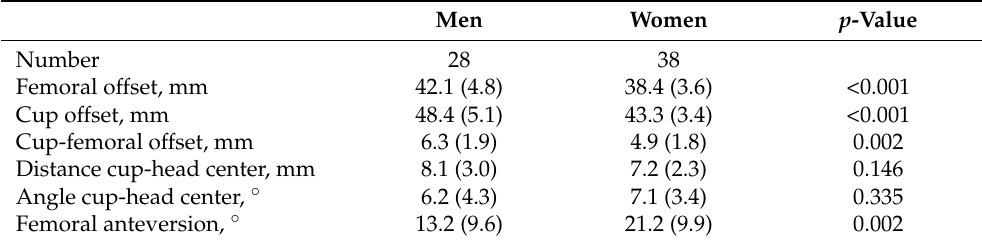
Figure 5. ( A ) Distribution of the three-dimensional femoral and cup offsets. ( B ) Correlation between the three-dimensional cup and femoral offsets. Table 2. Three dimensional parameters.